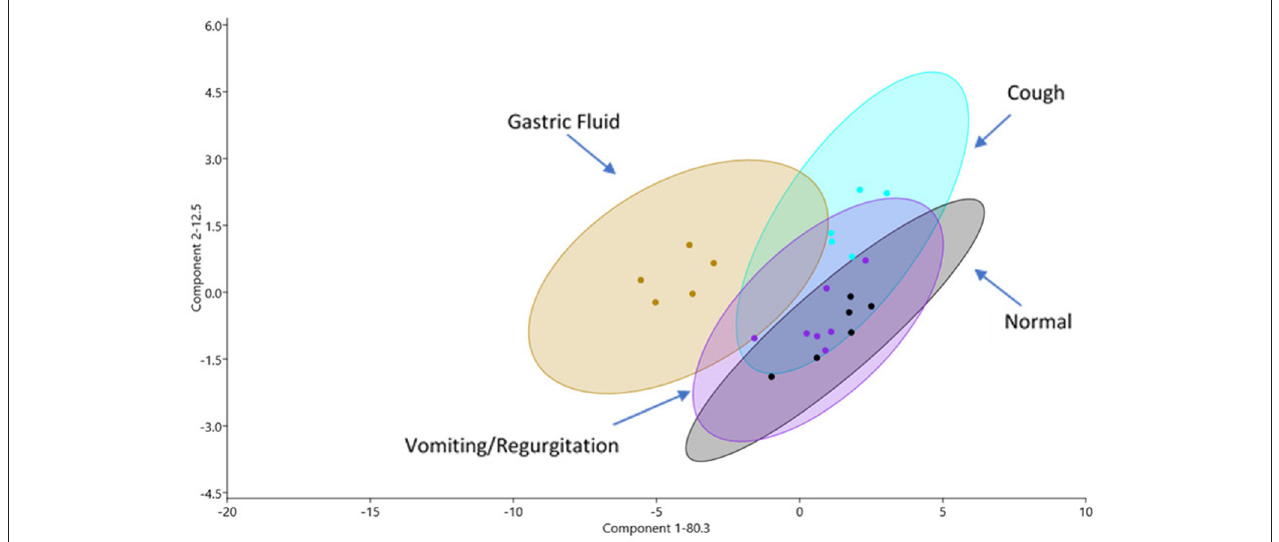
FIGURE 1 | Proteomic profiles as shown via principal component (PC) analysis of samples for all four sample sites: GF (yellow), normal OP (gray), coughing OP (blue), and vomiting/regurgitating OP (purple). Similarities in proteomic profiles are demonstrated by overlapping regions on the PC1 vs. PC2 plot. Each dot represents an individual sample, and the ellipses represent 95% confidence intervals. GF, gastric fluid; OP,